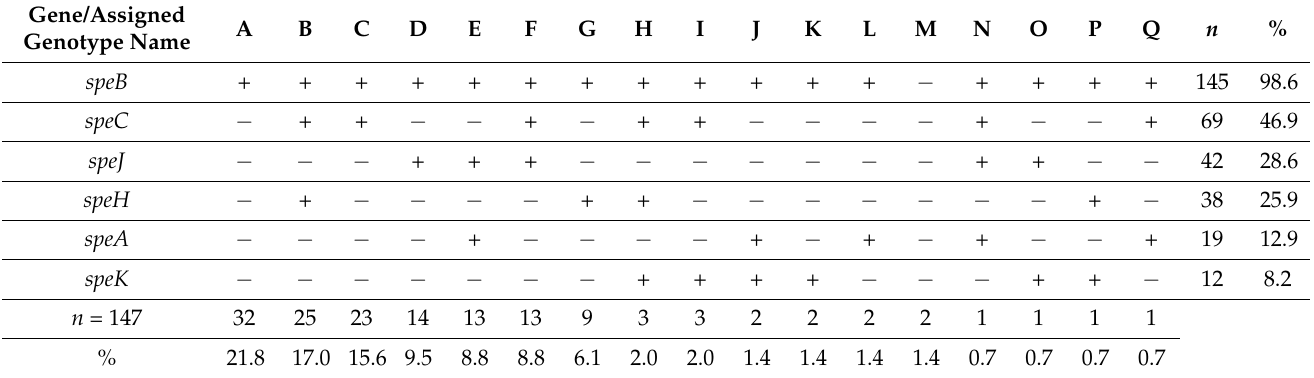
Table 1. The percentages of genes presence and genotype distribution among the examined